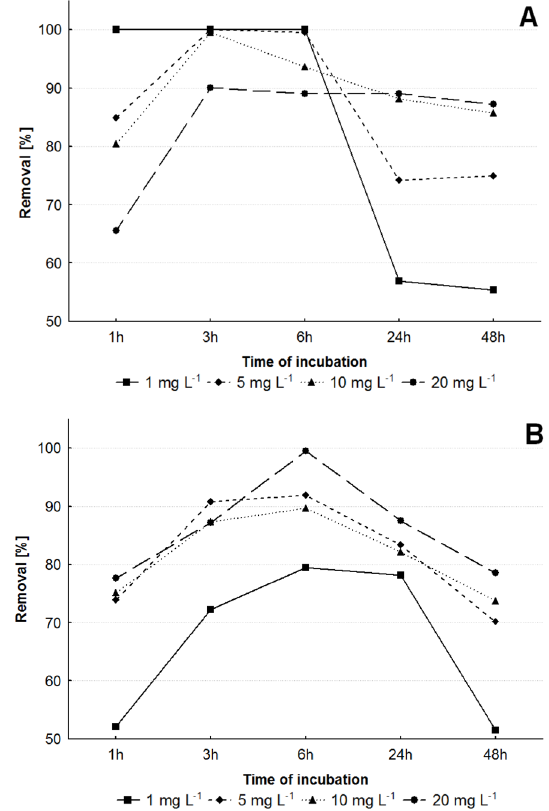
Figure 1. The effect of treatment time on biosorption of Pb (A) and Cd (B) by M. aeruginosa